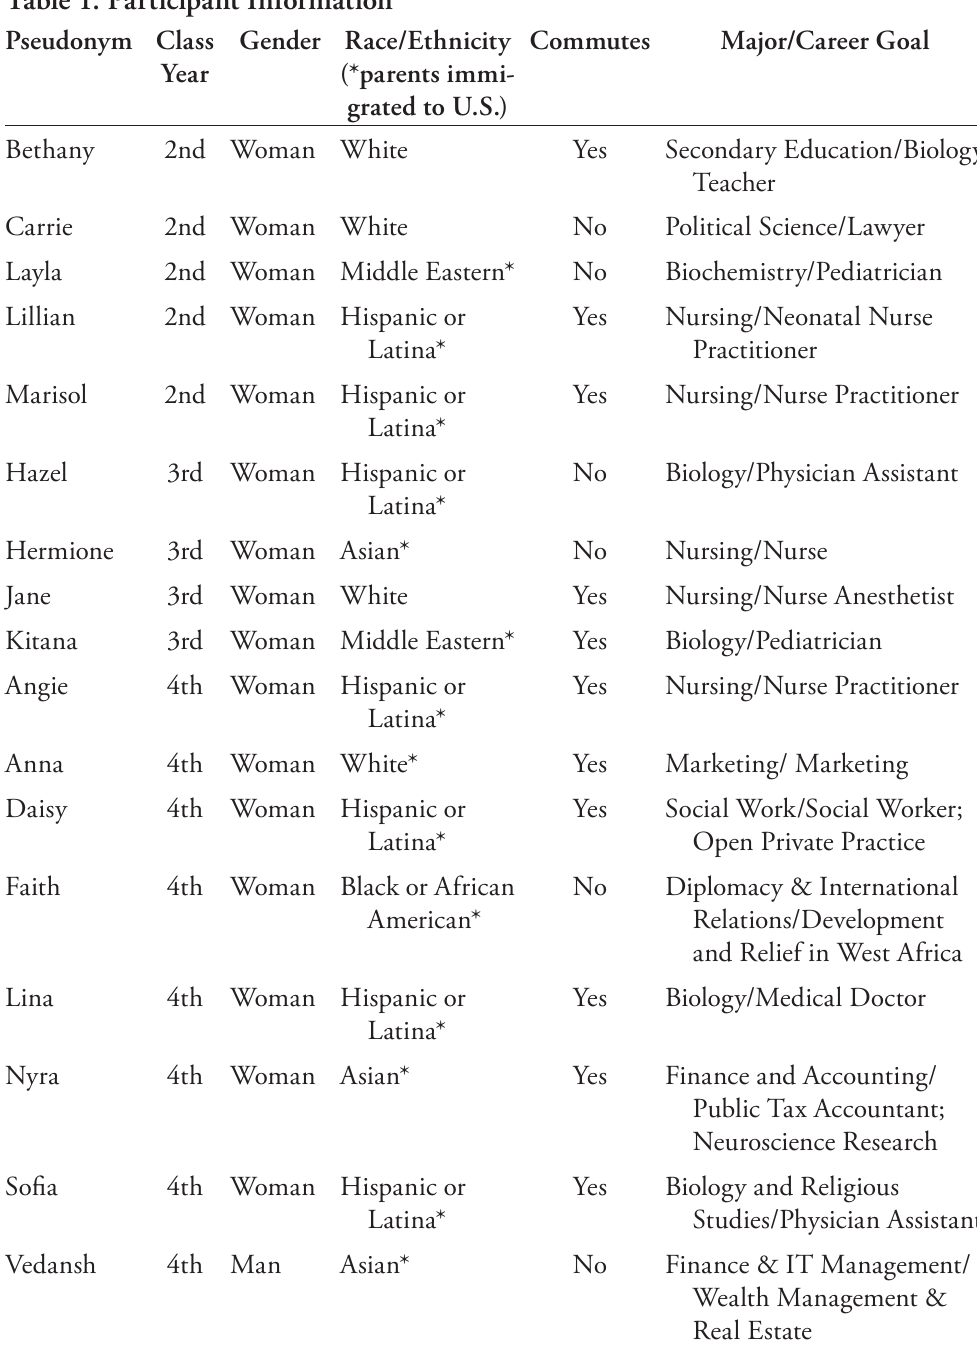
Table 1. Participant Information Pseudonym